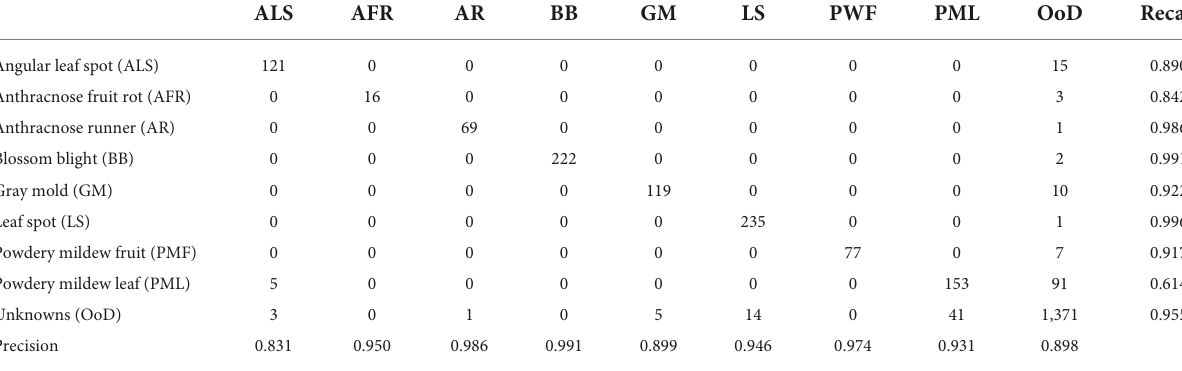
TABLE 6 Confusion matrix of the retrained